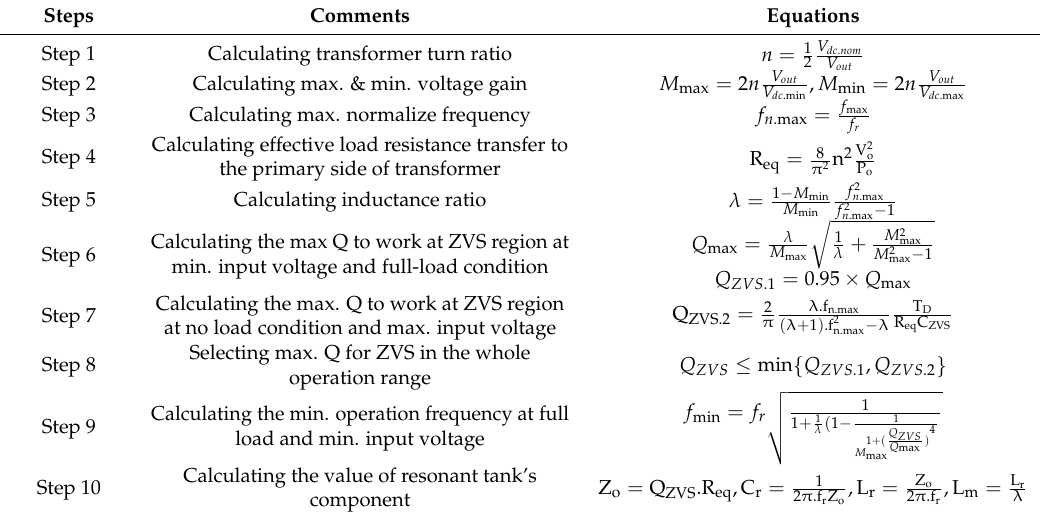
Table 1. Procedure of LLC resonant half-bridge converter design